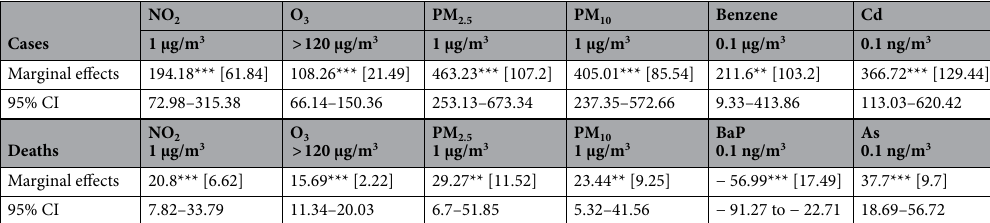
Table 8. The average marginal effects got from negative binomial regressions. CI confidence interval. p-value < 0.01***; p-value < 0.05**. Standards errors in